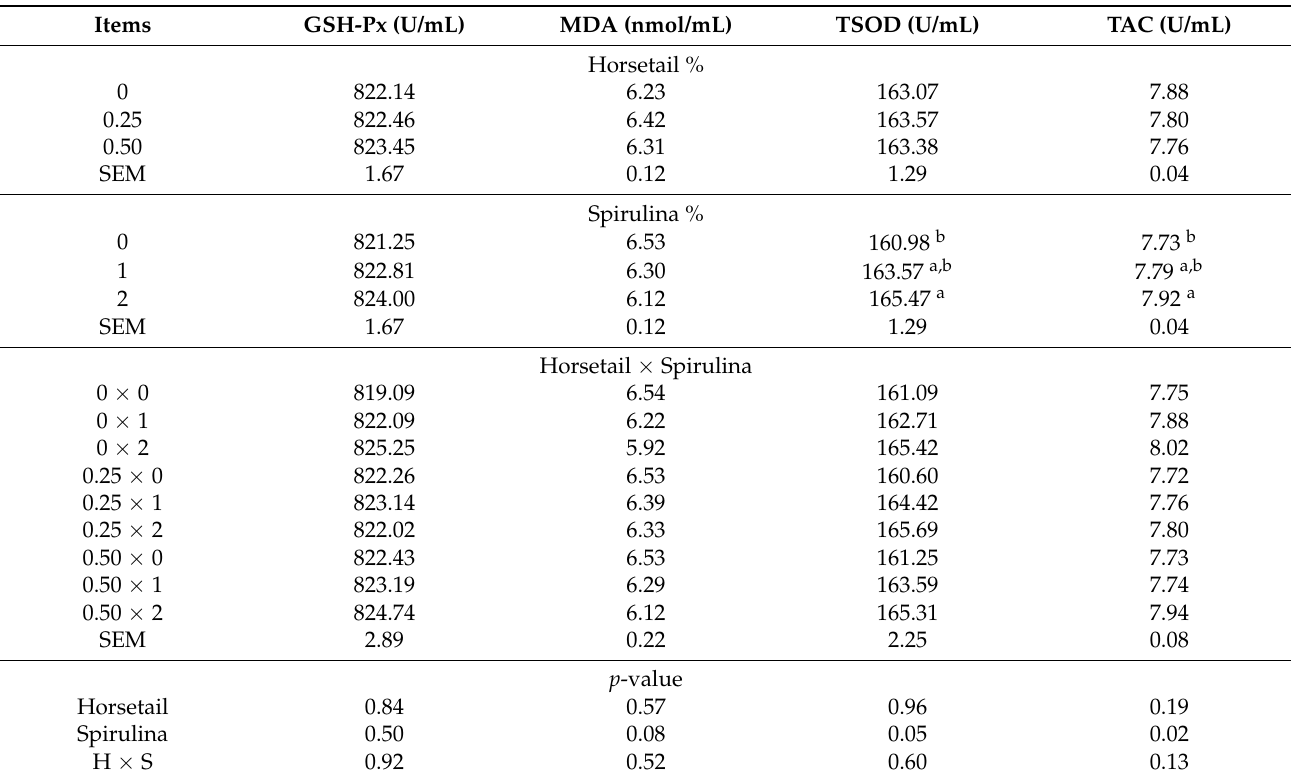
Table 8. Effect of experimental diets on serum glutathione peroxidase (GSH-Px) activity, malondialdehyde (MDA), total superoxide dismutase (TSOD), and total antioxidant capacity